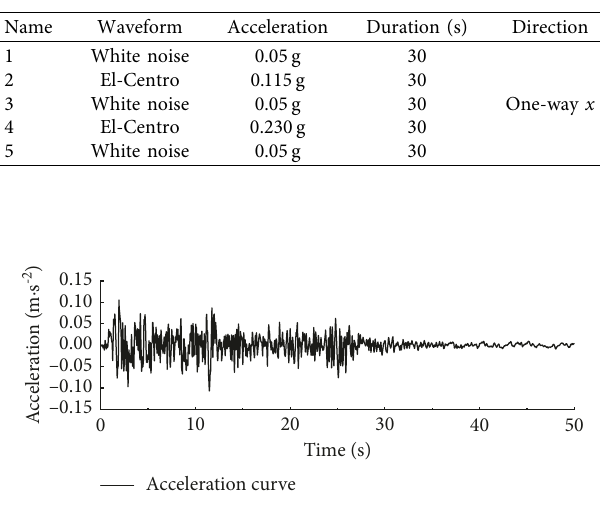
Figure 9: Acceleration time history of El-Centro wave.